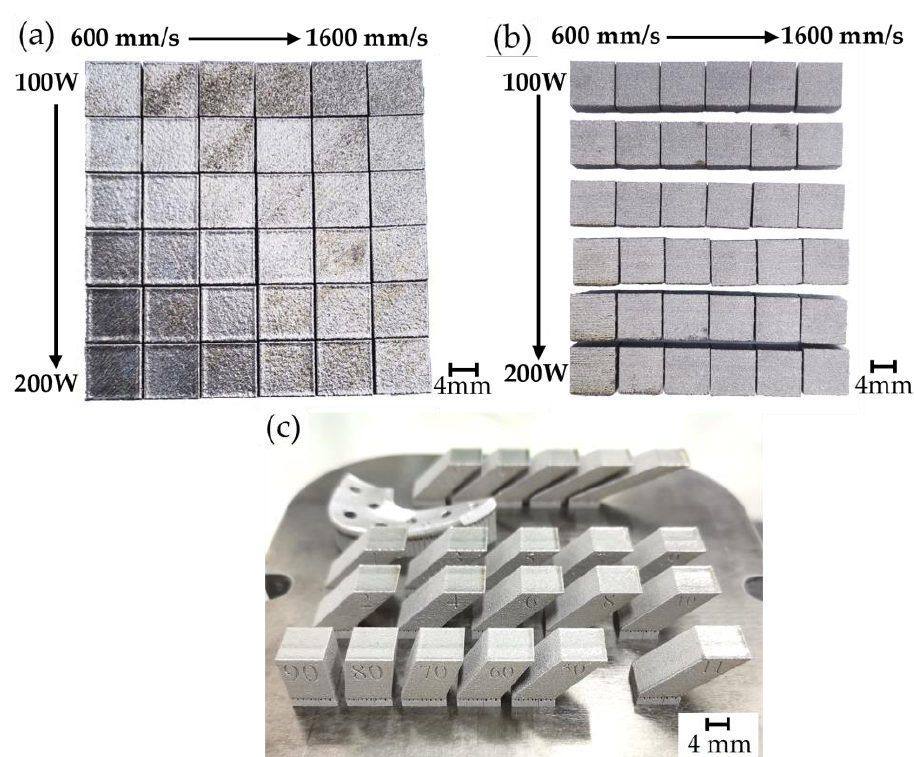
Figure 2. Forming effect of specimens: ( a ) upper surfaces of cube specimens; ( b ) vertical sides of cube specimens; ( c ) oblique square specimens.